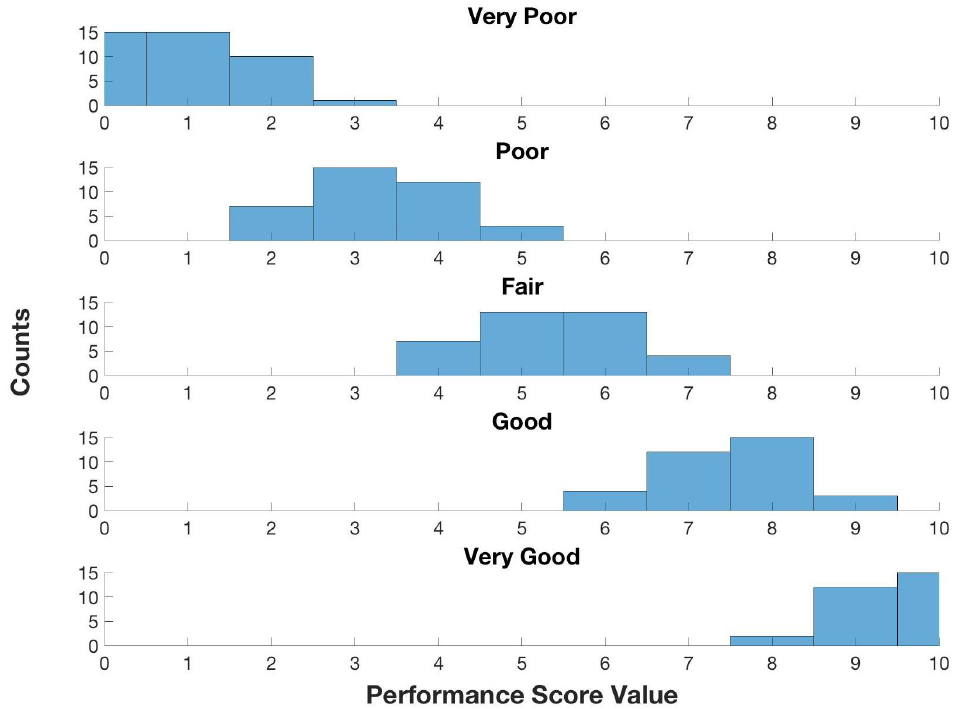
Figure A2. Histogram of polled data associating linguistic terms referring to an overall performance score with numerical values (5MF